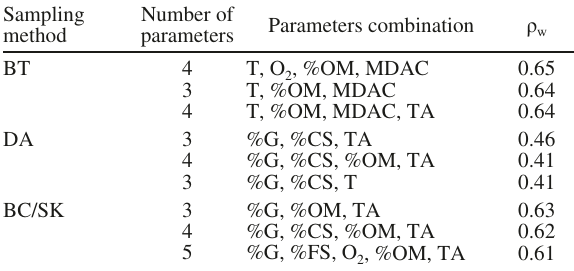
Table 6. – BIOENV analysis results based on Spearman rank correla- tions ( ρ ), showing the set of parameters that best explain the molluscan w assemblage patterns of the Gazul mud volcano detected with differ- ent sampling methods. BT, beam-trawl; DA, benthic dredge; BC/SK, box-corer and Shipek grab. T, water temperature; O , dissolved oxygen 2 concentration; %OM, % of organic matter; MDAC, availability of methane-derived authigenic carbonates; TA, bottom-trawling activity; %G, % of gravel; %CS, % of coarse sand; %FS, % of fine